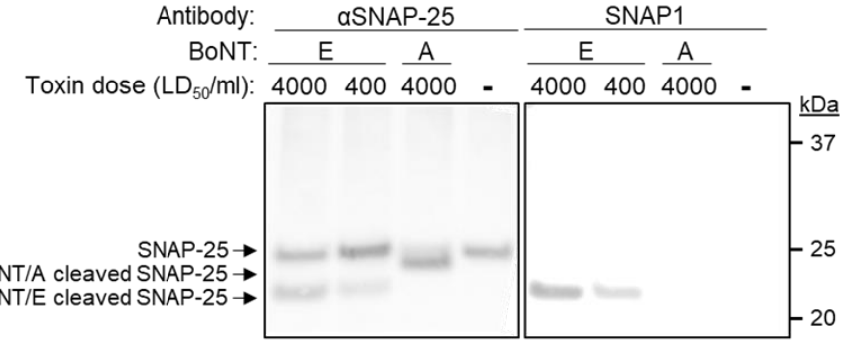
Figure 6. Specific detection of cleaved SNAP-25 neoepitope by SNAP1 antibody. Differentiated SiMa cells were exposed to the indicated doses of either BoNT/A or BoNT/E and lysed 24 h after intoxication. Lysates were subjected to SDS-PAGE and Western-blotted using either anti-SNAP-25 polyclonal antibody or SNAP1.